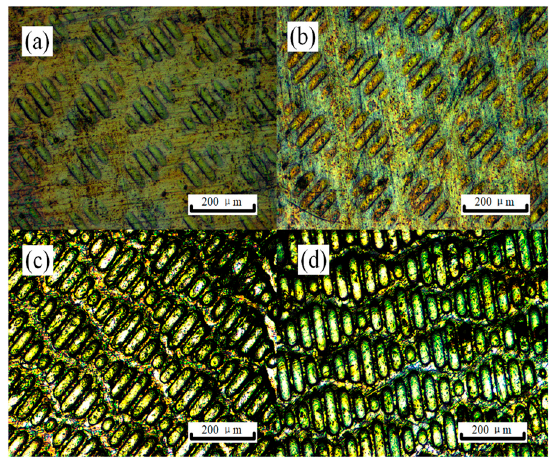
Figure 8. Micrographs of the sharklet patterns obtained by EA micro-embossing at different current densities: ( a ) 0 A / mm 2 , ( b ) 6 A / mm 2 , ( c ) 10 A / mm 2 , ( d ) 13 A / mm 2 .